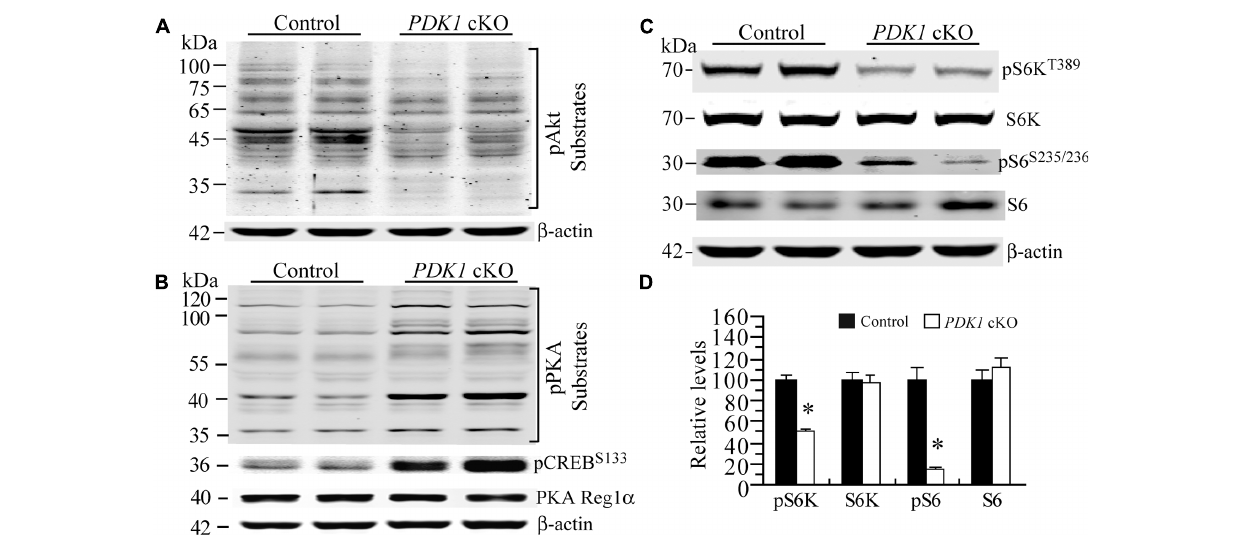
FIGURE 7 | Enhanced PKA activity but decreased mTORC1 activity in PDK1 cKO mice. (A) Western blotting for pAkt substrates. Several bands for Akt downstream targets were decreased in PDK1 cKO mice ( n = 3 mice/group). (B) Western blotting for pPKA substrates, pCREB and PKA Reg1 α . Several PKA downstream targets exhibited increased levels in PDK1 cKO mice. Levels for pCREB Ser133 but not PKA Reg1 α were increased ( n = 3 mice/group). (C) Western blotting for pS6K and pS6 in control and PDK1 cKO mice. (D) There were significant differences on relative levels of pS6K and pS6 between control and PDK1 cKO mice at 3 months ( n = 3 mice/group; ∗ p < 0.05). There were no significant differences on levels of total S6K and S6 between control and PDK1 cKO mice ( p s > 0.5). β -actin was used as the loading